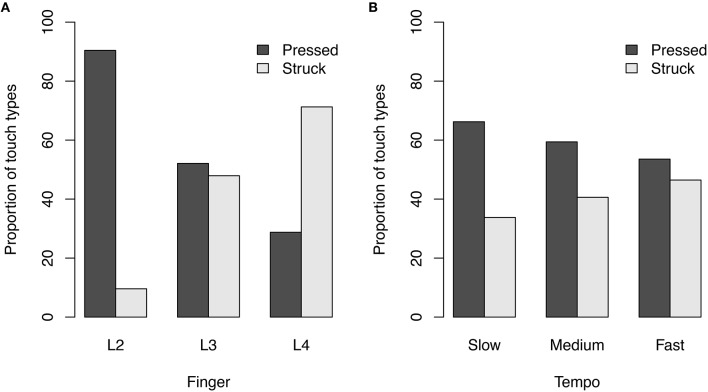
(A) The proportion of touch types in the technical exercise task for the individual fingers (L2 = index finger, L3 = middle finger, L4 = ring finger) of the left hand varied. (B) The proportions of touch types for three tempo conditions shows that with faster tempi the number of struck touches increased.